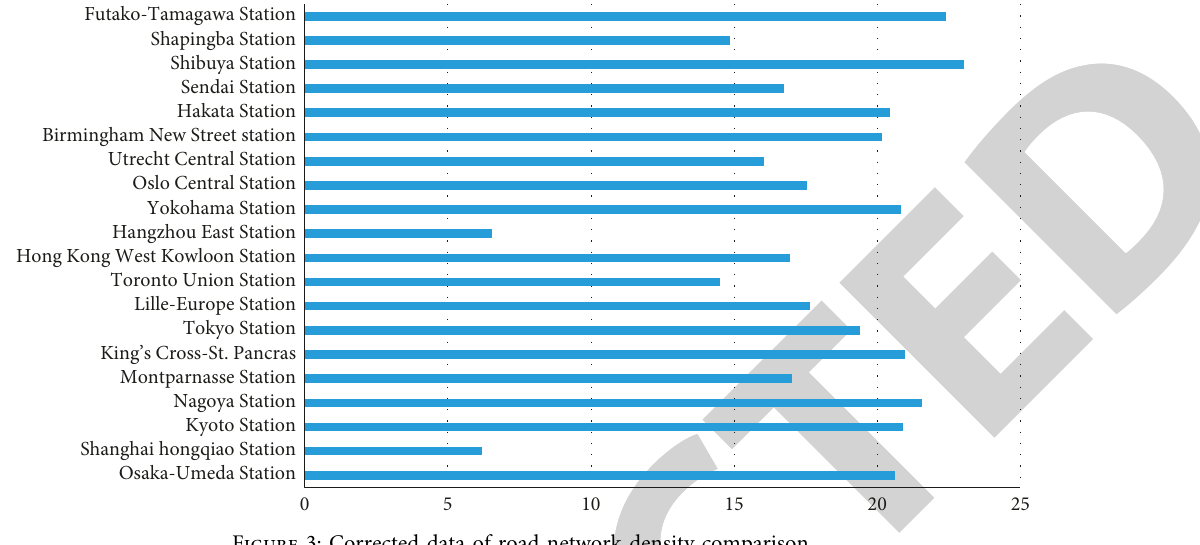
Figure 3: Corrected data of road network density comparison.